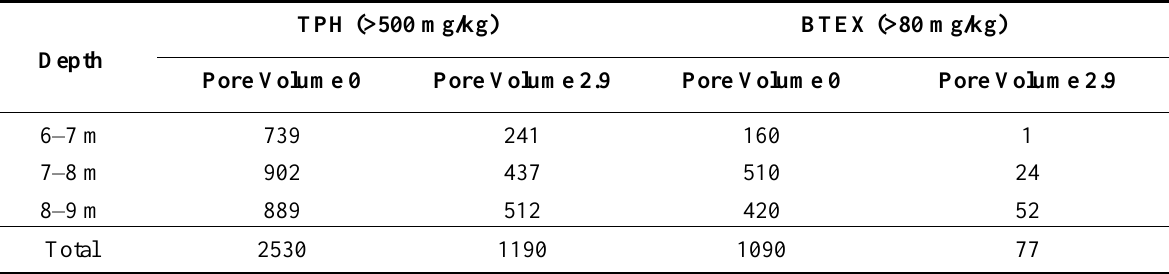
Table 6. The area polluted by TPH and BTEX (Unit: m 2